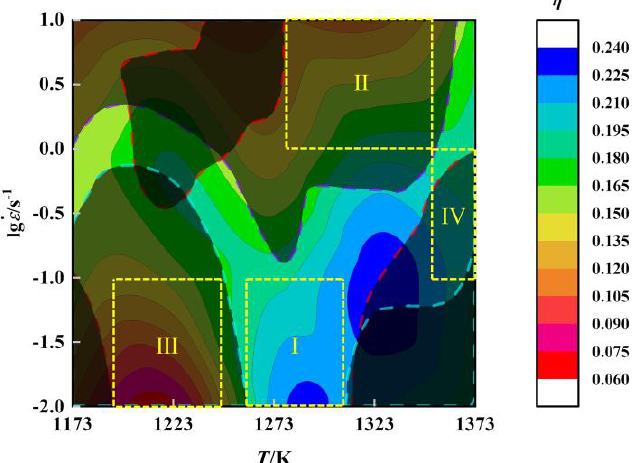
Figure 10. Processing map with the true strain of 0.9. The purple dotted area is the instability region obtained by the instability parameter ξ , the cyan dotted areas are the instability regions obtained by the m ̇ criterion, the red dashed areas are the instability regions obtained by the S ̇ criterion, and the colored areas represent the η values.